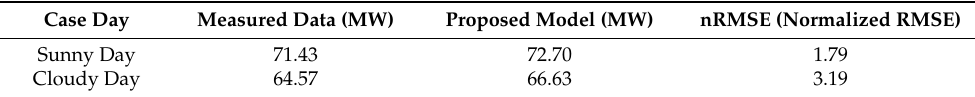
Table 7. Comparison of the results on a sunny day and a cloudy day.